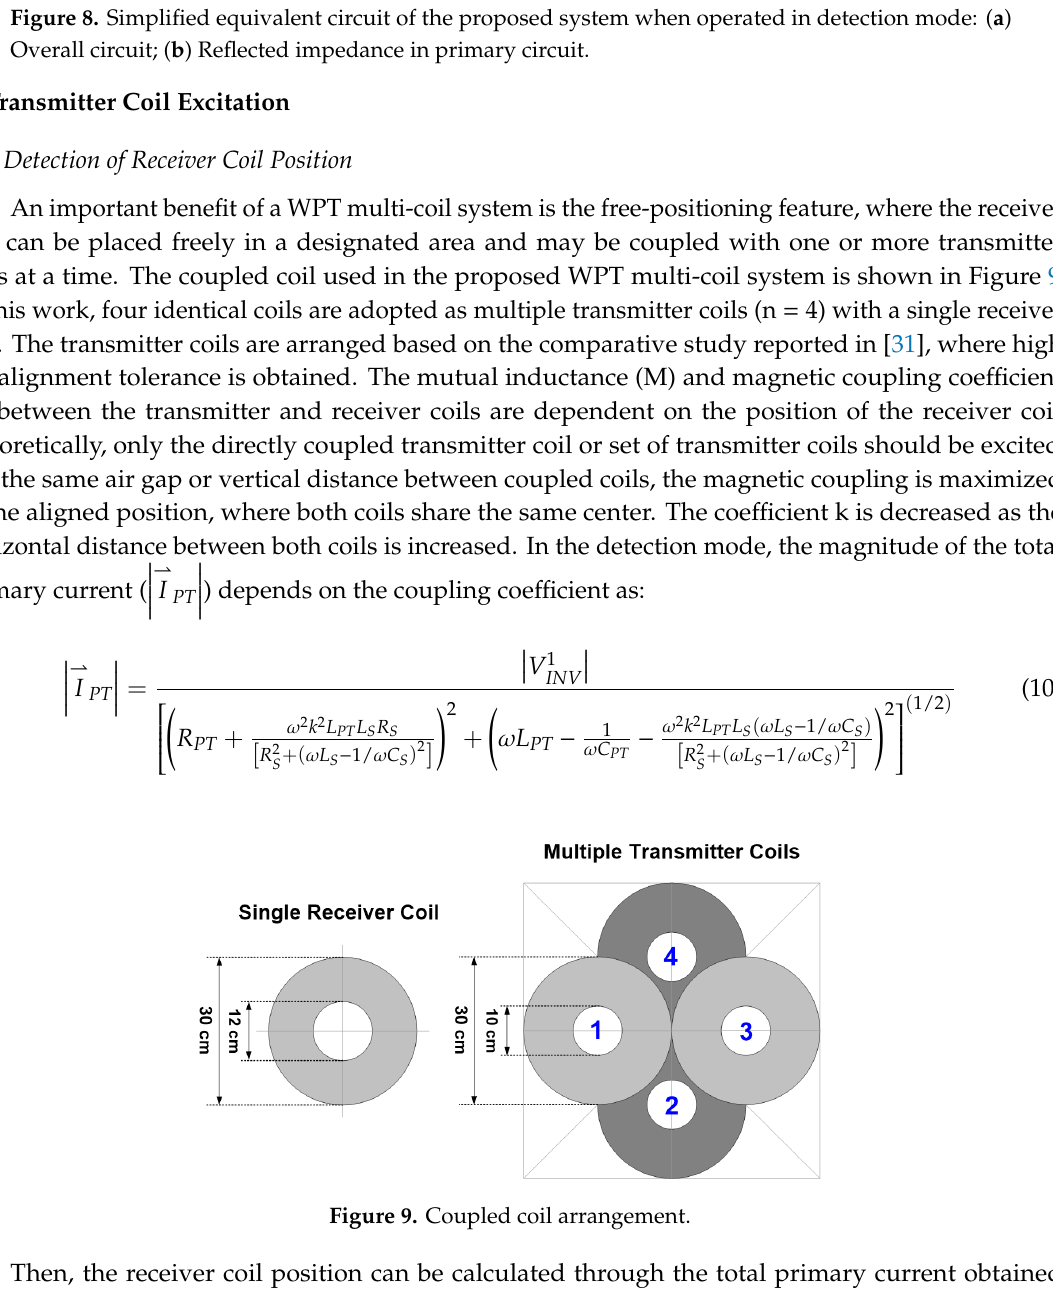
Figure 9. Coupled coil arrangement.